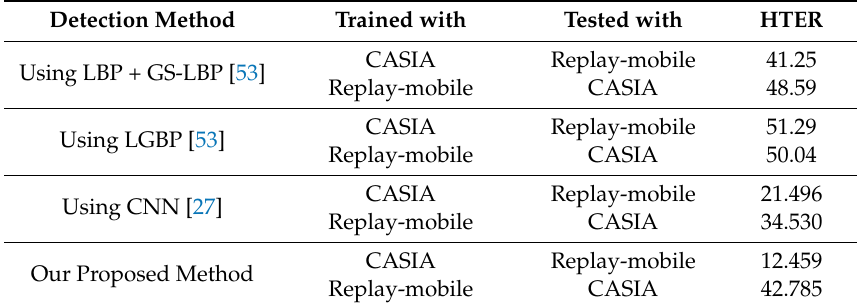
Table 13. Comparison of detection error (HTER) produced by our proposed method with the previous study by Peng et al. for the cross-dataset setup (unit: